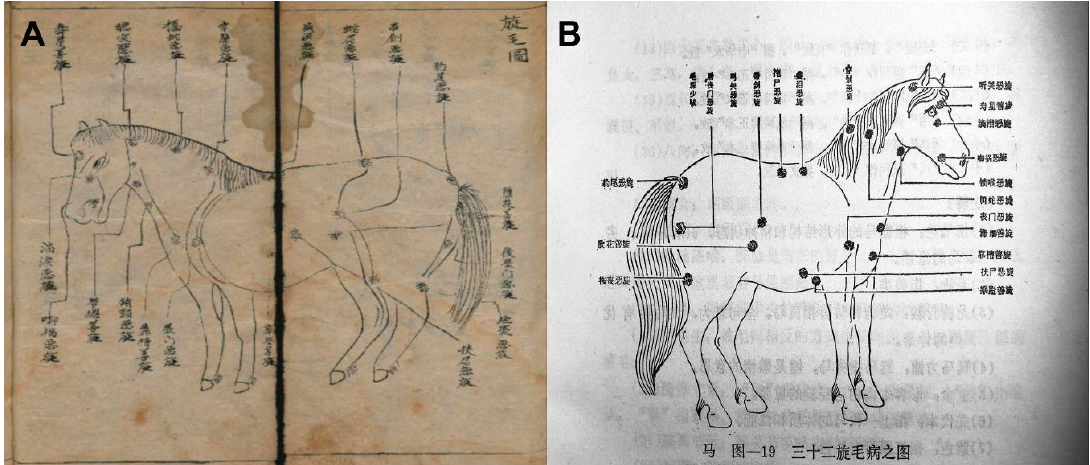
Figure 3. Different versions of the hair whorls illustration. (A) The illustration of hair whorls quoted Figure 3. Di ff erent versions of the hair whorls illustration. ( A ) The illustration of hair whorls quoted by the author. (B) The illustration of hair whorls in Yuan Heng Liao Ma Ji printed in 1990 [16] . by the author. ( B ) The illustration of hair whorls in Yuan Heng Liao Ma Ji printed in 1990